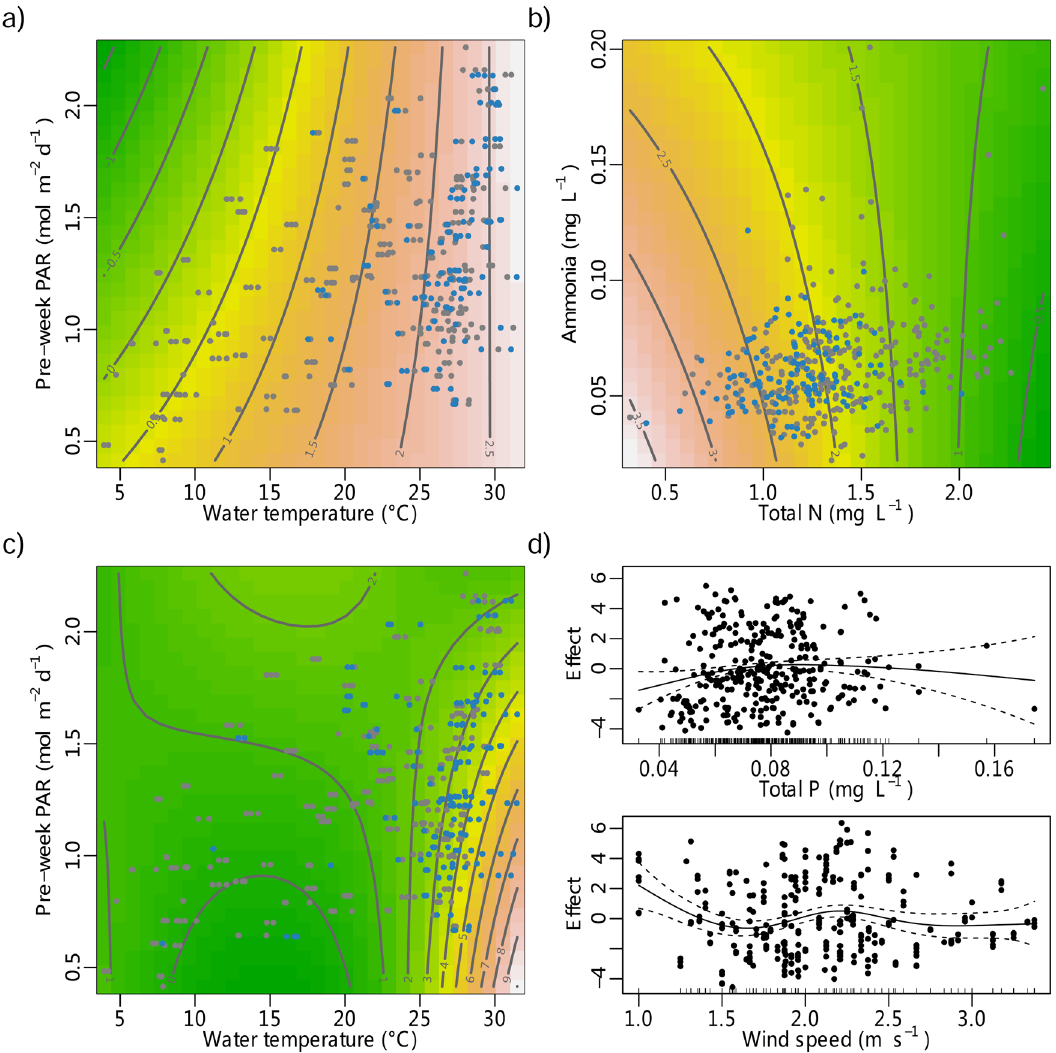
Fig. 4 Illustration of niche models (GAM3 and GAM4) of two fi lamentous cyanobacteria. a Effects surface for water temperature and pre- week PAR on growth of Planktothrix . b Summed effects surface for total N and ammonia on growth of Planktothrix . c Summed effects surface for water temperature and pre-week PAR on growth of Pseudanabaena . d Partial effects of total P and wind speed on growth of Pseudanabaena . In in a , b , and c , the contour colors and lines indicate the predicted logarithms of cell densities (log 10 (1 + N), cells L − 1 ) in the two genera (from low to high represented by green to bright orange); gray dots represent the absences of the corresponding genus and purple dots represent the presences. In d lines are smoothed effect of total P (top) and wind speed (down) on growth of Pseudanabaena , dots are partial residuals of model